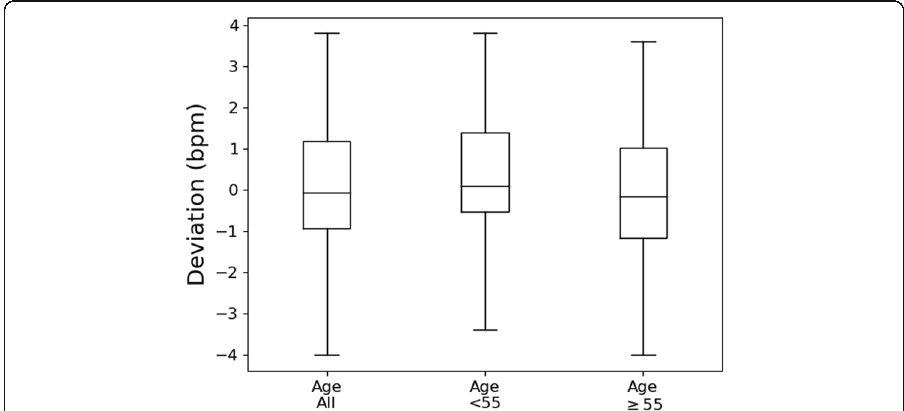
Fig. 6 Box plot of deviations between the proposed method of respiratory rate measurement and